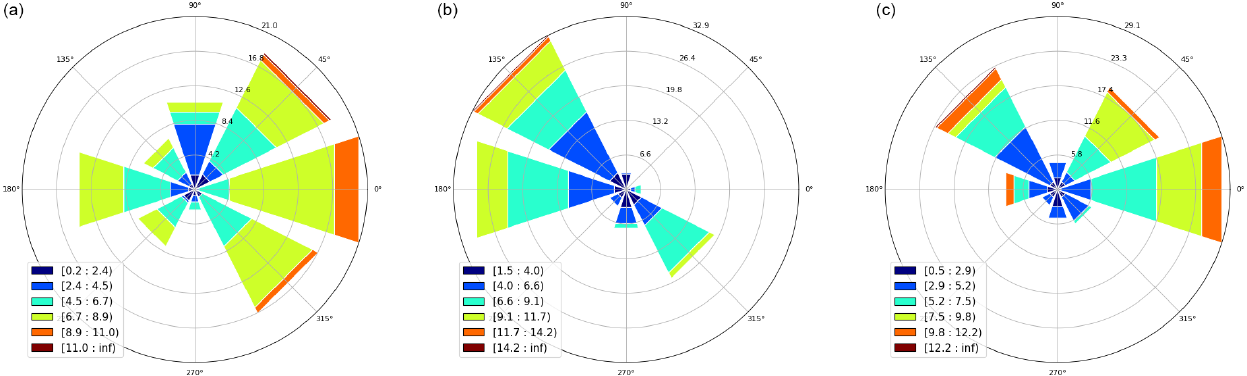
Figure 7. Wind roses derived from measurements of the weather station Wettermast Hamburg at an altitude of 110m. Results for three periods covering about 15d each are shown: 16–31 March 2020, 1–15 April 2020 and 16–30 April 2020, from left to